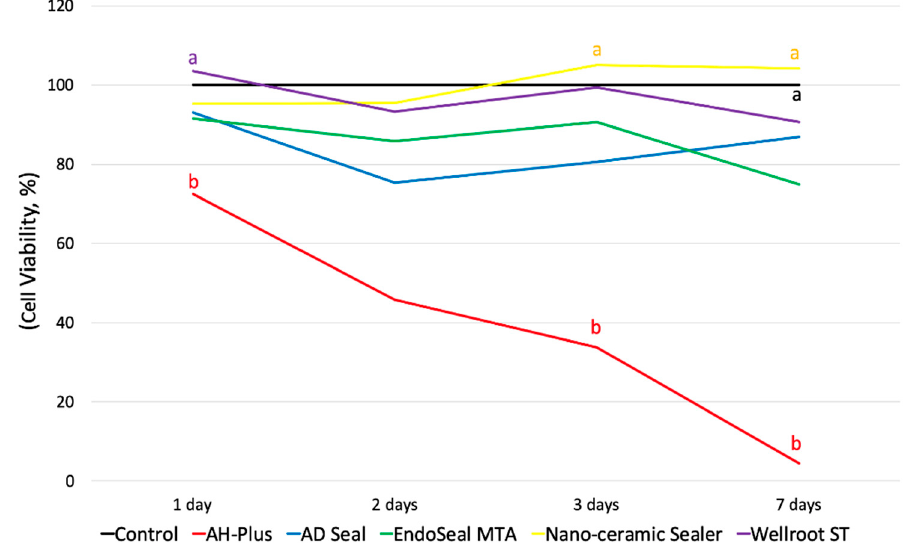
Figure 2 . Cell viability of human periodontal ligament stem cells (hPDLSCs) by 3-(4,5- dimethylthiazolyl-2-yl)-2,5-diphenyltetrazolium bromide (MTT) assay using extraction media